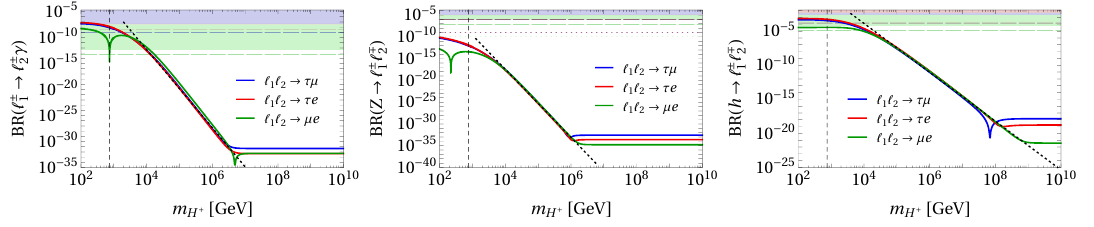
; all the other parameters are H + = 750 GeV. H +